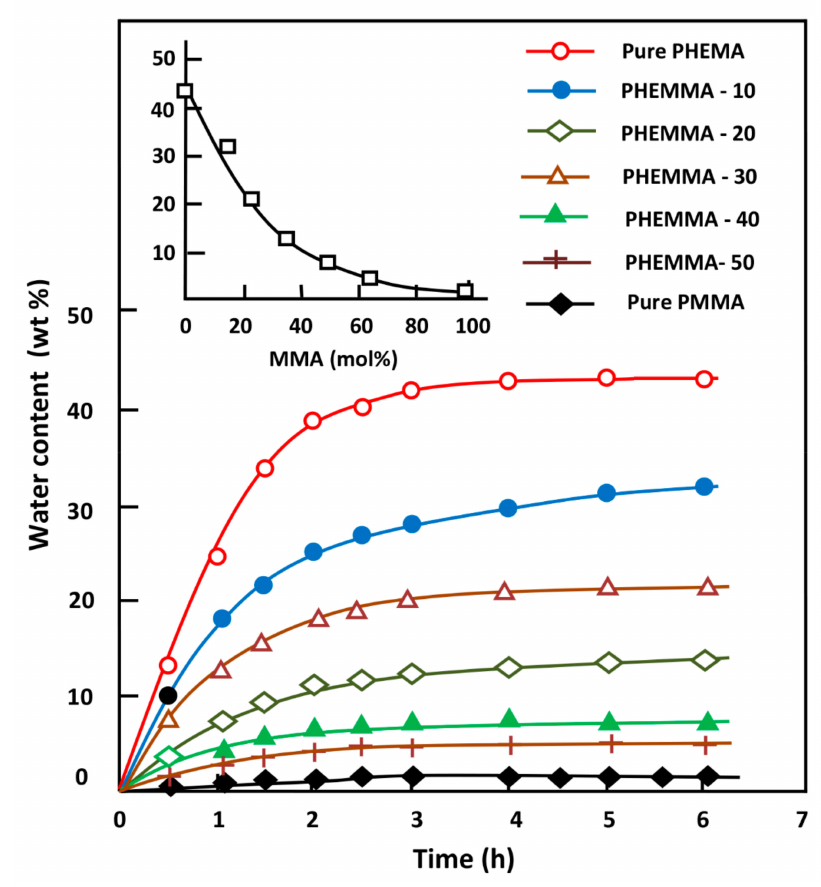
Figure 7. Variation of the equilibrium water content (EWC) in the PHEMMAC specimens and in their components versus time and the MMA content (top